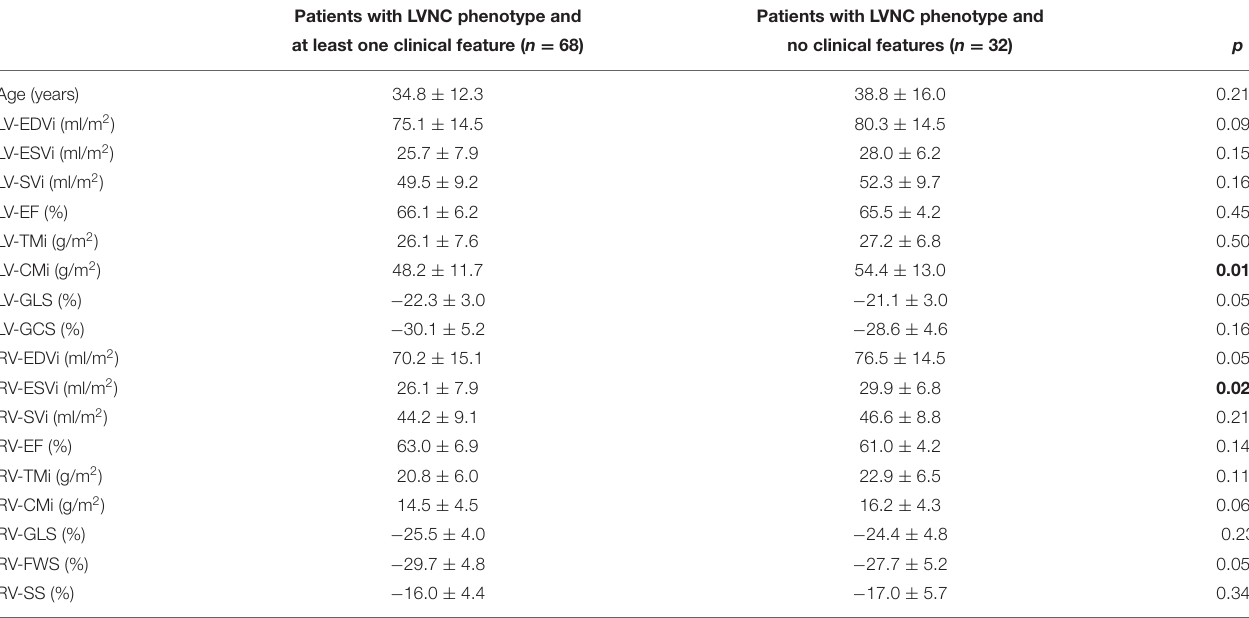
TABLE 5 | Comparison of the left and right ventricular parameters of the patients with LVNC phenotype and at least one clinical feature and the patients with LVNC phenotype and no clinical features. Patients with LVNC phenotype and Patients with LVNC phenotype and at least one clinical feature ( n =